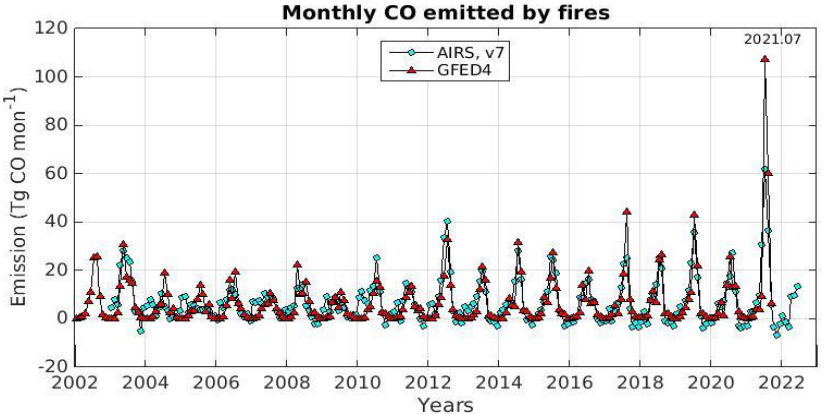
Figure 4. Monthly CO emissions from fires estimated from AIRS data and compared with GFED4c results [3] https://www.geo.vu.nl/~gwerf/GFED/GFED4c/.(accessed on 7 May 2022).